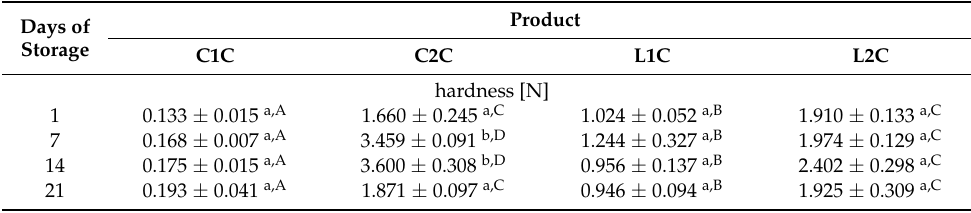
Table 2. Texture parameters of buttermilk quark cheeses during the